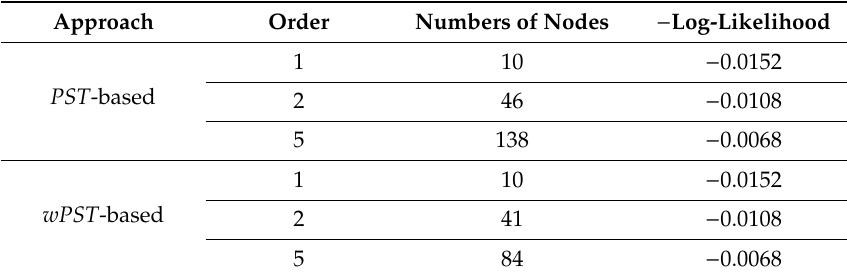
Table 9. Comparison of the wPST vs. PST